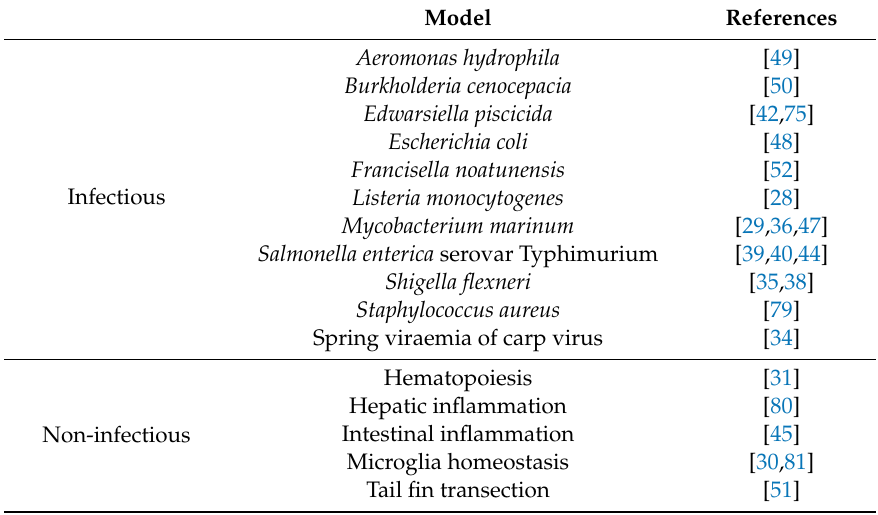
Table 3. Infectious and non-infectious zebrafish models in which inflammasome function has been